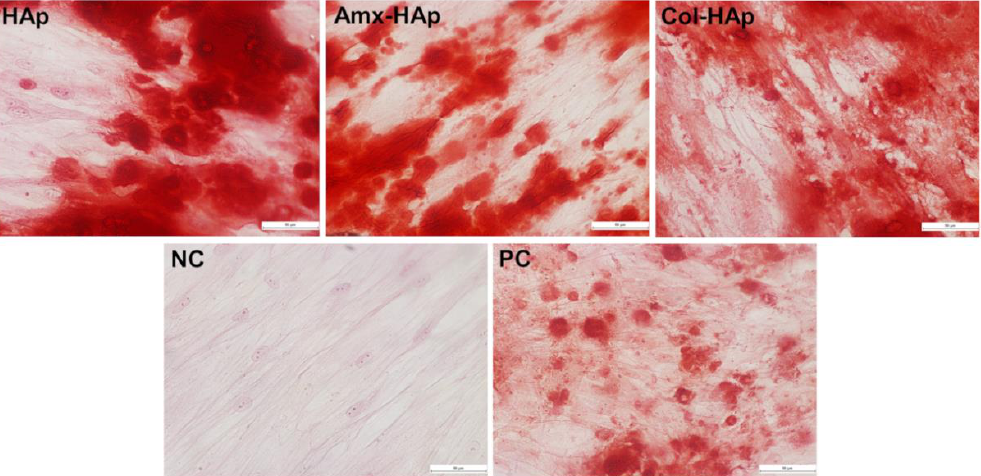
Figure 5. Induction of osteogenic differentiation of hDPSCs by the biomaterials tested in this study. HAps, hydroxyapatite nanosheet-assembled microspheres; Amx–HAp, amoxicillin–hydroxyapatite composite; Col–HAp, collagen–hydroxyapatite composite; NC: negative control; PC: positive control. Calcium crystals were present in the HAps, Amx–HAp, Col–HAp, and the positive control.